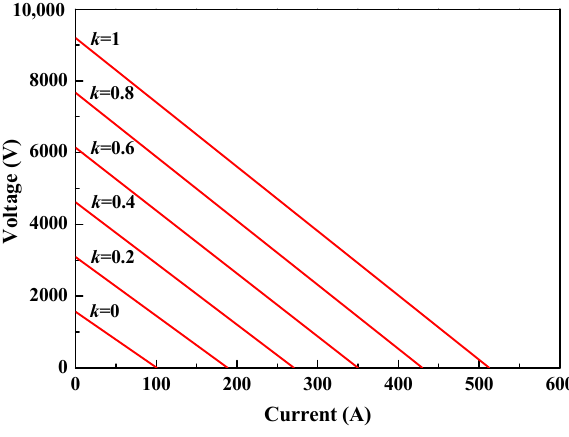
Figure 18. U-I characteristic of external system at different fault location.